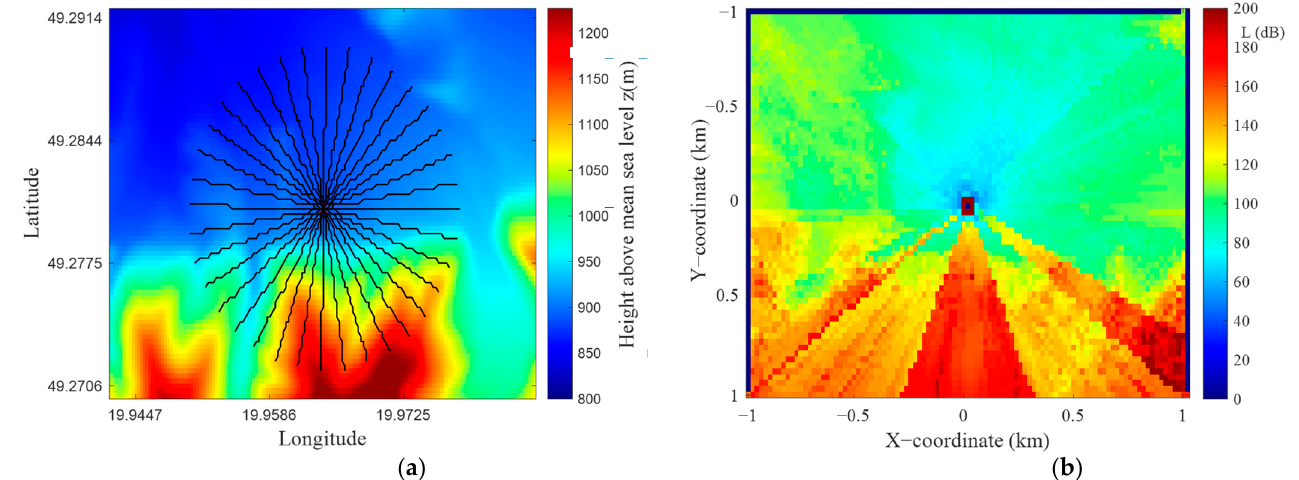
Figure 11. ( a ) DTED-based elevation map for selected TX location, ( b ) reference PAM for angular resolution Δα = 1°.